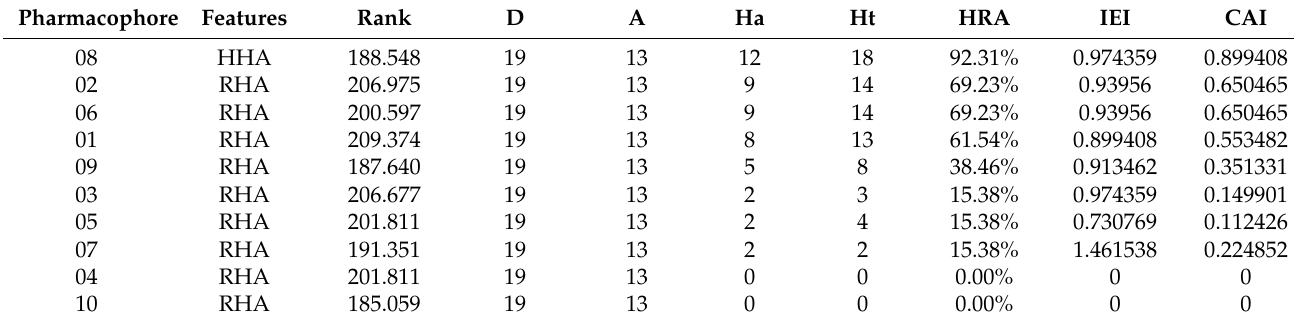
Table 1 . The test scores of the pharmacophore models. Table 1. The test scores of the pharmacophore models.